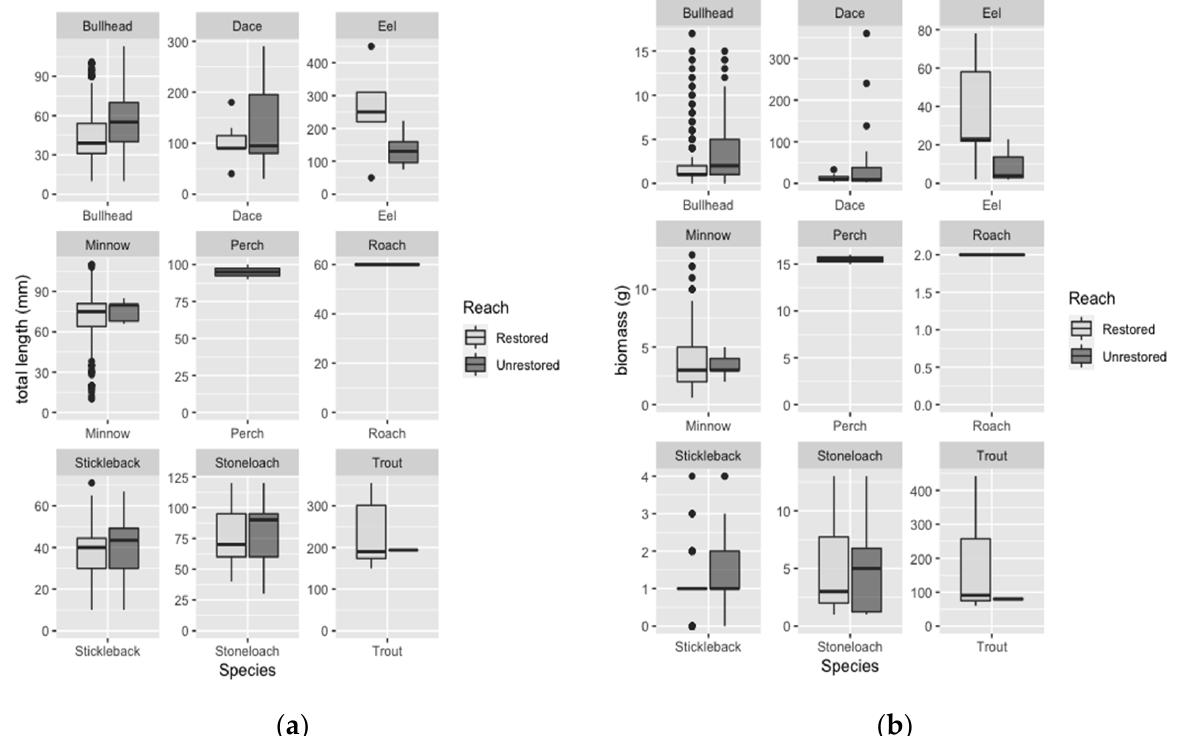
Figure 4. ( a ) Individual total length (mm) and ( b ) individual biomass (g) across 9 different species collected during the